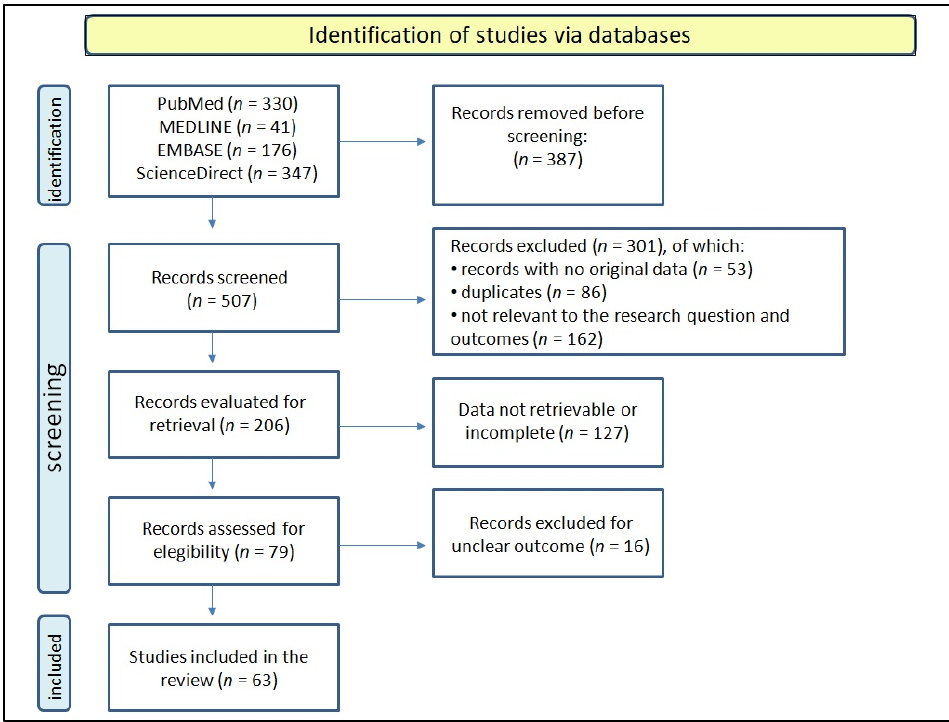
Figure 1. A schematic representation illustrating the process of study